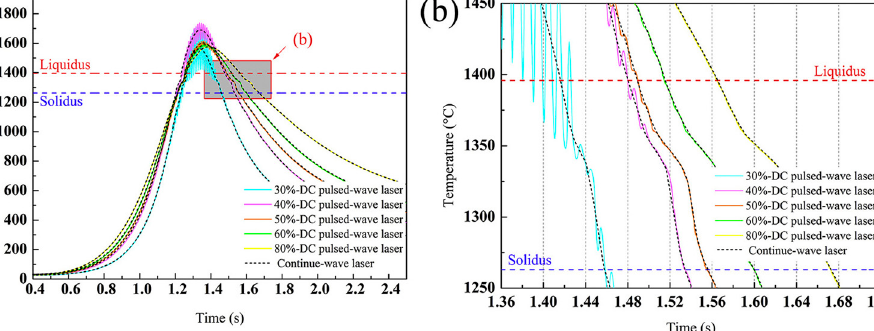
Figure 3. ( a ) Temperature history at the point that is 120 µ m above the bonding interface in the depositions with different duty cycles, and ( b ) Enlargement of the shaded part in ( a ). (Reprinted from ref. [33], copyright (2020), with permission from Elsevier). Table 2. Cooling rate around 1370 °C and dendrite spacing of K447A alloy deposition [33].